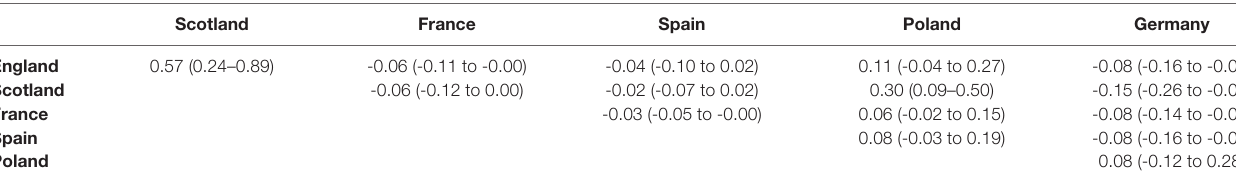
TABLE 6 | Agreement in recommendations between countries for all analyzed drugs.